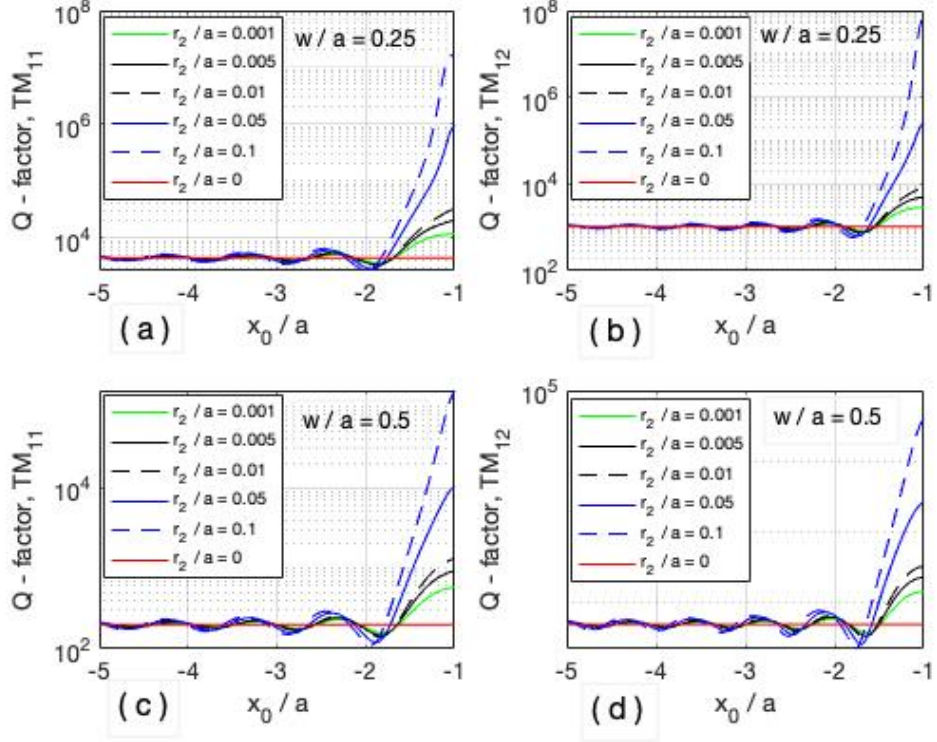
Figure 10. 𝑄 factor of complex eigenmodes ( 𝑇𝑀 (cid:2869)(cid:2869) , 𝑇𝑀 (cid:2869)(cid:2870) ) versus relative distance 𝑥 (cid:2868) 𝑎⁄ for rectan- lar slotted cavities with wires ( r 2 / a = 0.001, 0.005, 0.01) and thin circular cylinders ( r 2 / a = 0.05, 0.1 ) : gular slotted cavities with wires ( 𝑟 (cid:2870) 𝑎 = 0.001, 0.005, 0.01⁄ ) and thin circular cylinders ( a ) Q 11 , w / a = 0.25; ( b ) Q 12 , w / a = 0.25; ( c ) Q 11 , w / a = 0.5; ( d ) Q 12 , w / a = (𝑟 𝑎 = 0.05, 0.1⁄ ) : ( a ) 𝑄 , 𝑤 𝑎⁄ = 0.25 ; ( b ) 𝑄 𝑤 𝑎⁄ = 0.25 ; ( c ) 𝑄 𝑤 𝑎⁄ = 0.5 ; ( d ) 𝑄 𝑤 𝑎⁄ = (cid:2870) (cid:2869)(cid:2869) (cid:2869)(cid:2870) , (cid:2869)(cid:2869) , (cid:2869)(cid:2870) , 0.5 .